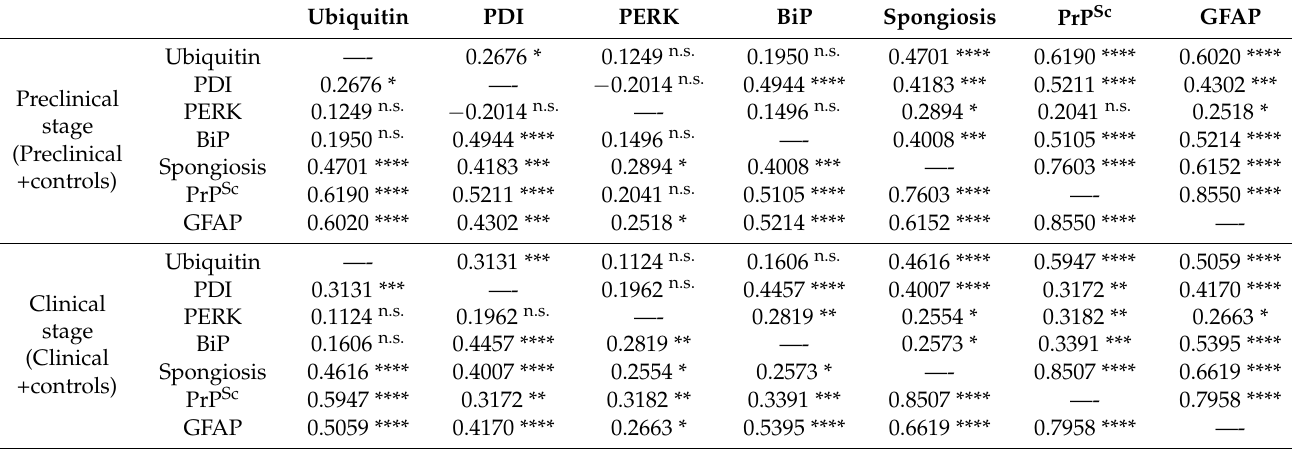
Table 1. Spearman’s correlation values between scores of endoplasmic reticulum (ER) stress and proteasome impairment and prion-associated histopathological lesions. Correlations were estimated using the full set of data obtained in all brain areas. n.s.: no statistically significant value. Spearman’s correlation * p < 0.05, ** p < 0.01, *** p < 0.001 and **** p <